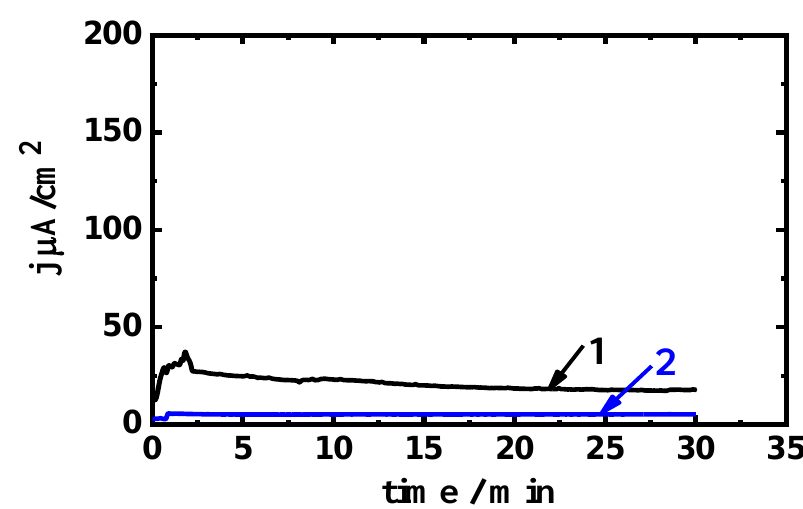
Figure 11. Change of current with time at 300 mV for (1) Ti-6%Al and (2) Ti-6%Al-4%V alloys after immersion in 3.5% NaCl solution for 48 h.